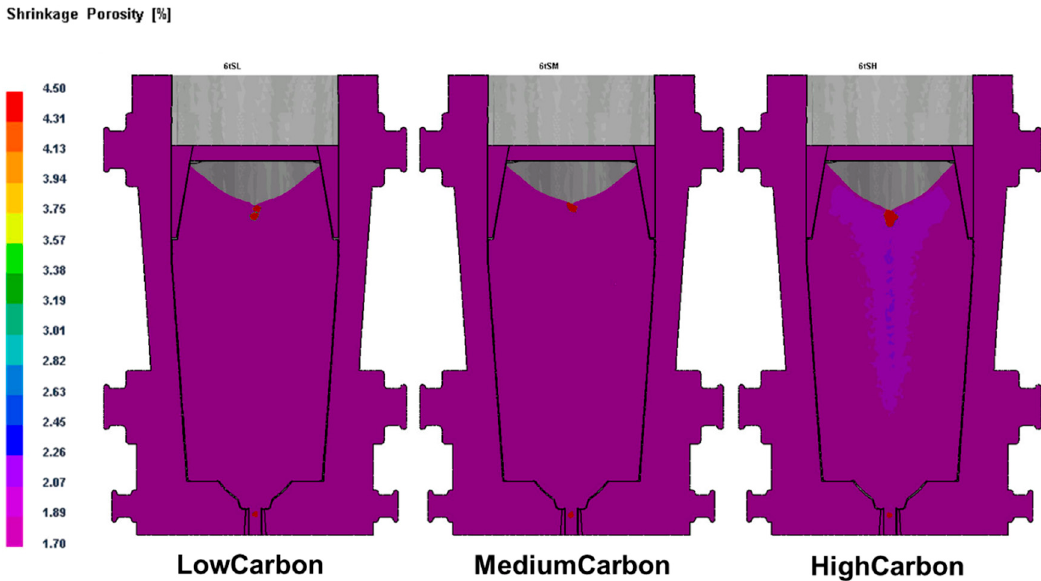
Figure 5. Simulation of style of ferrite formation in carbon steels.